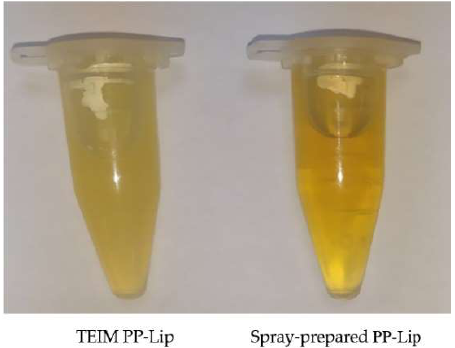
Figure 2. Macroscopic examination of the typical ethanol injection method (TEIM)-prepared and spray-prepared PP-Lip.